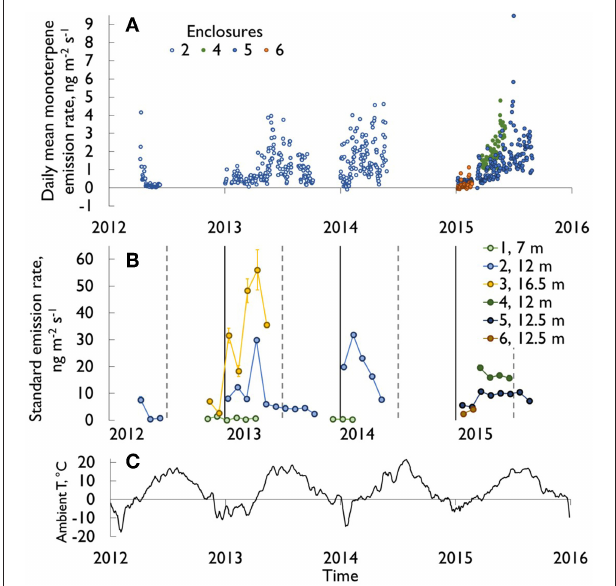
FIGURE 2 | (A) Monoterpene emission rates (diurnal means, ng m − 2 s − 1 ) of within-canopy stem enclosures at a height of about 12m in all studied trees during the measurement period 2012–2015. (B) The corresponding standardized monoterpene emissions (ng m − 2 s − 1 ) and their 95% confidence intervals (calculated according to Guenther et al. (1993) with Ts = 30 ◦ C and β = 0.09 K − 1 ). Vertical solid lines indicate 1st January and dashed lines 1st July. The spring 2012 emission peak, reaching 40 ng m − 2 s − 1 , is excluded (see Vanhatalo et al., 2015). (C) Ambient temperatures at SMEAR II station 2012–2016, 14 days running